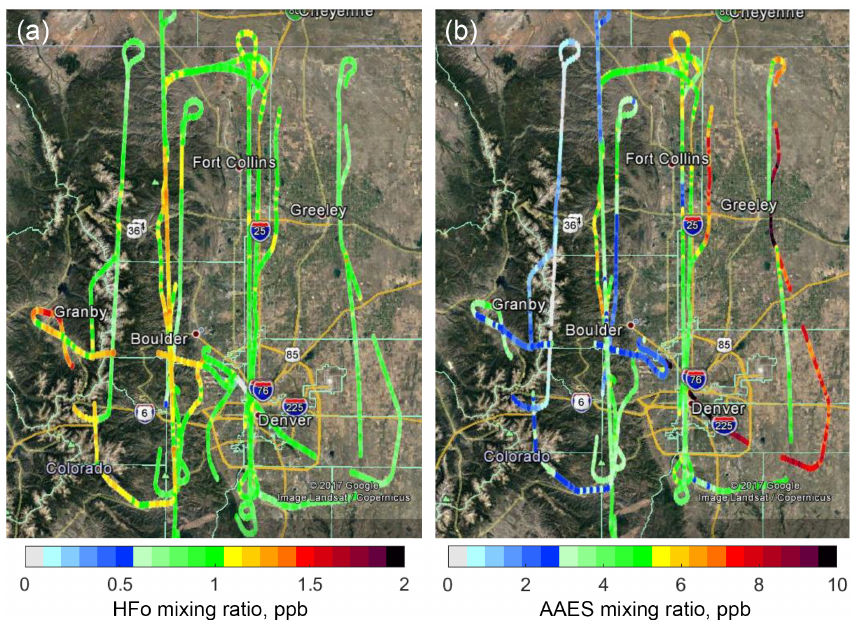
Figure 5. Mixing ratios, as parts per billion (ppb), for (a) formic acid (HFo) and (b) AAES (the sum of acetic acid and glycolaldehyde) for FRAPPÉ Research Flight 12 on 12 August